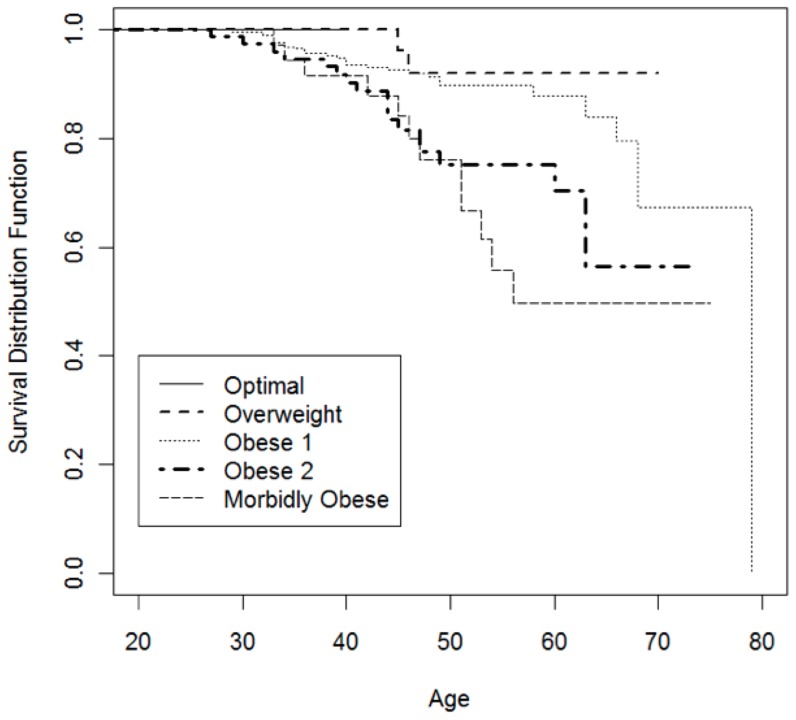
Survival probability for BMI by age for wrestlers.